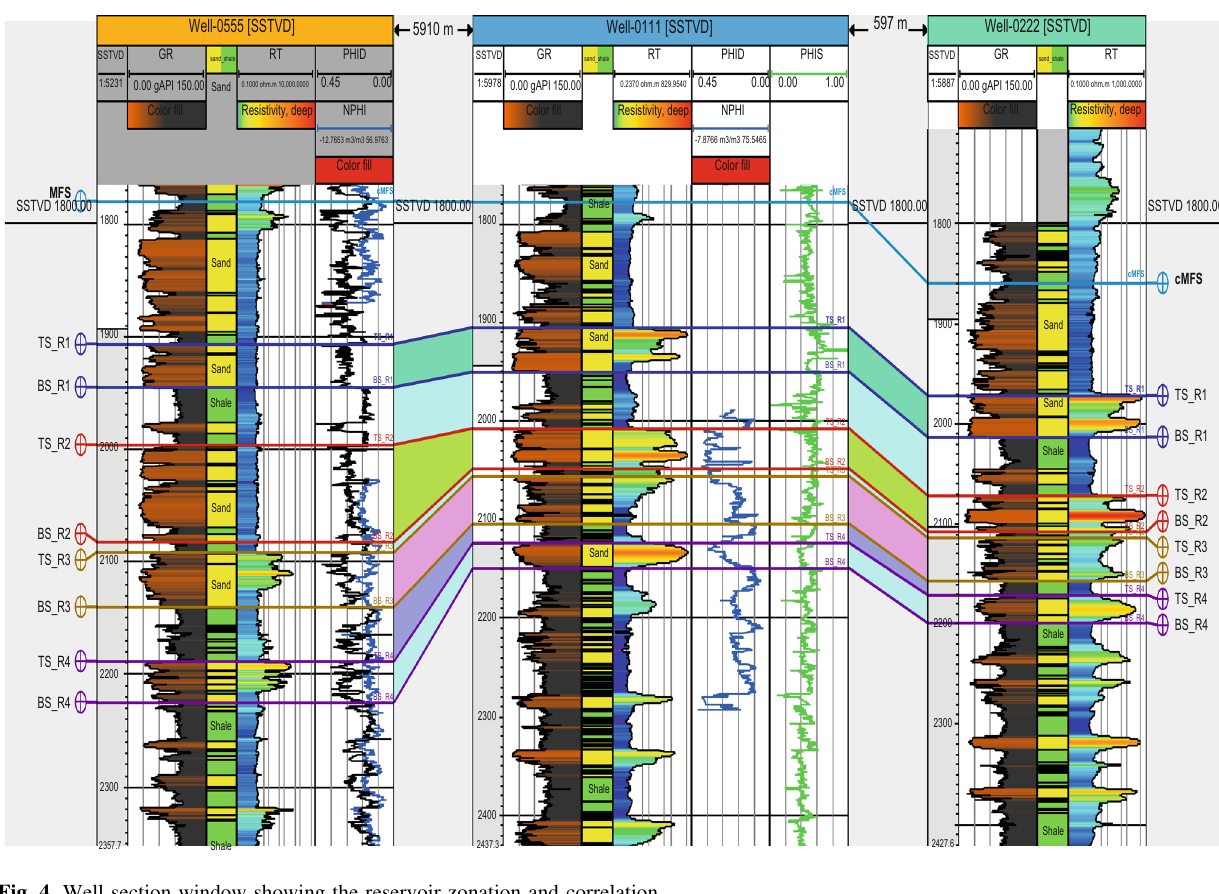
Fig. 4 Well section window showing the reservoir zonation and Porosity determination Porosity signifies the amount of voids or pore spaces in the rock volume, and the quantification of the amount of fluids the rock can hold. Both bulk density (RHOD) and neutron (NPHI) logs were utilized for porosity estimation using Asquith Eqs. (3) and (4) (Asquith and Krygowski 2004) for the hydrocarbon bearing reservoirs in well 0555. Wyllie time average Eq. (5) according to Wyllie et al. (1956) was used to estimate porosity from the sonic log. In a poorly consolidated, unconsolidated and/or uncompacted reservoir sand, a correction factor is necessary. Equation. (6)